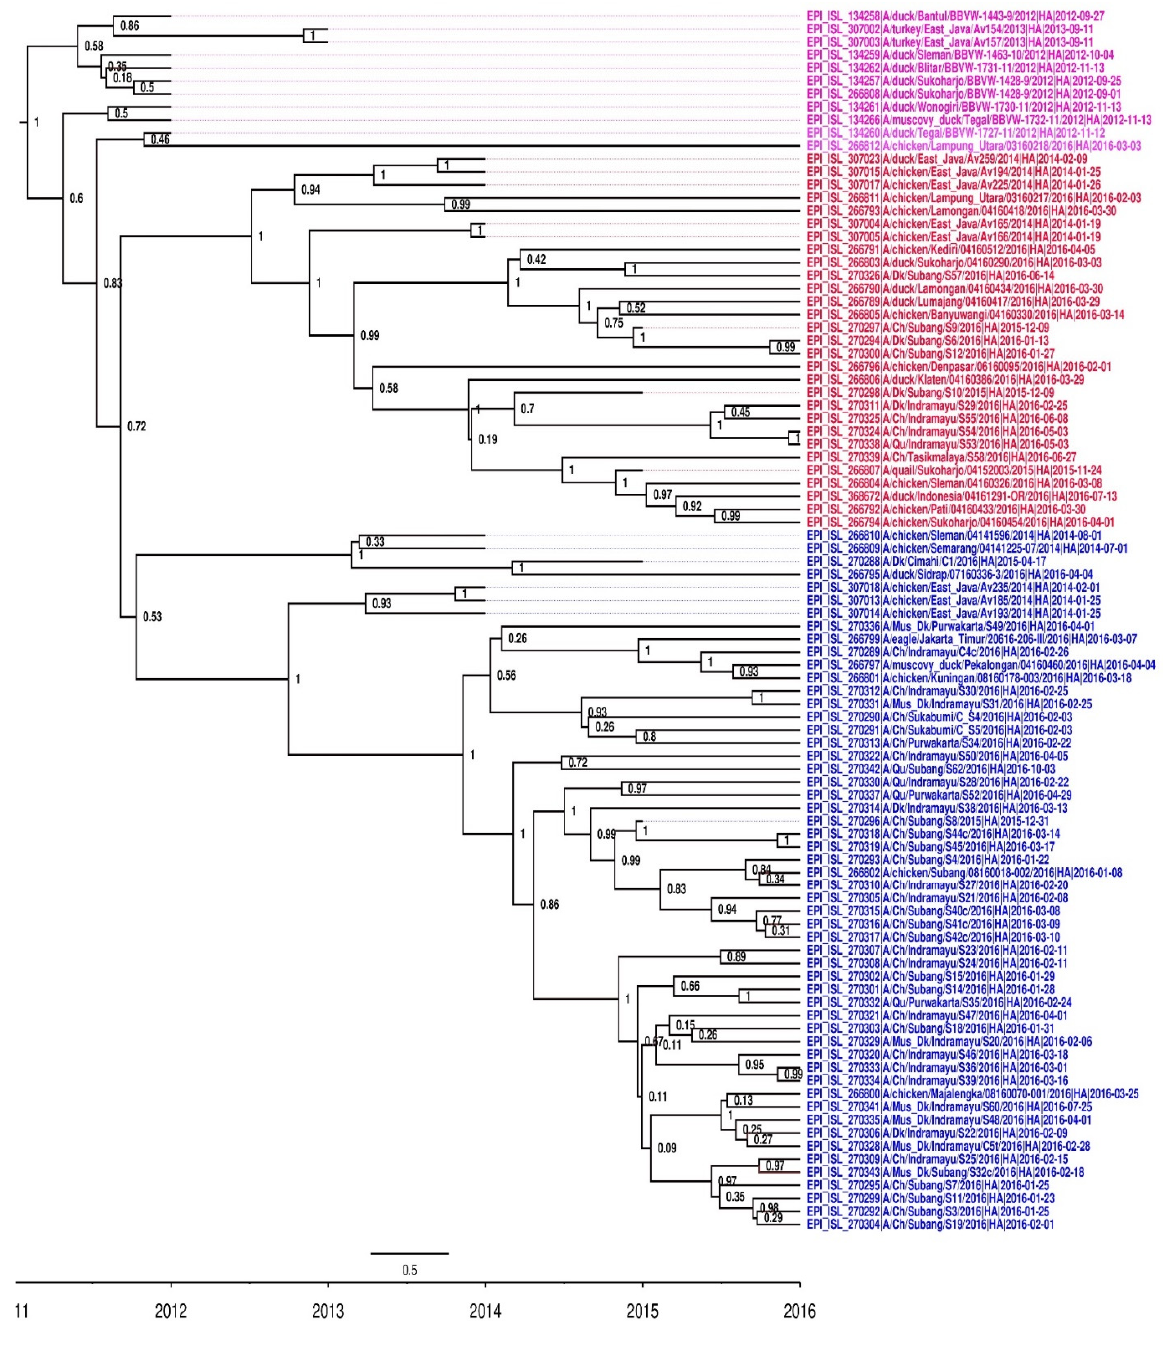
Figure A2. Time-scale phylogeny of Indonesian HA of H5N1v of HA genes of Indonesian poultry HPAIv A(H5N1) clade 2.3.2.1c. The clade 2.3.2.1c subgroup A is highlighted in red and clade 2.3.2.1c subgroup B is highlighted in blue. Another clade, 2.3.2.1c, is highlighted in pink. The node labels display the posterior value.